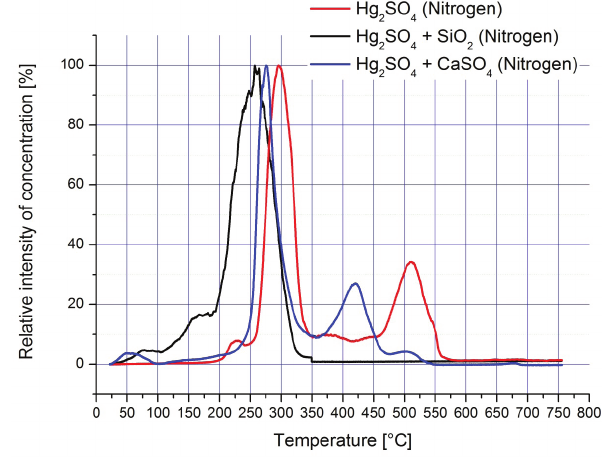
SO , purged with 2 4